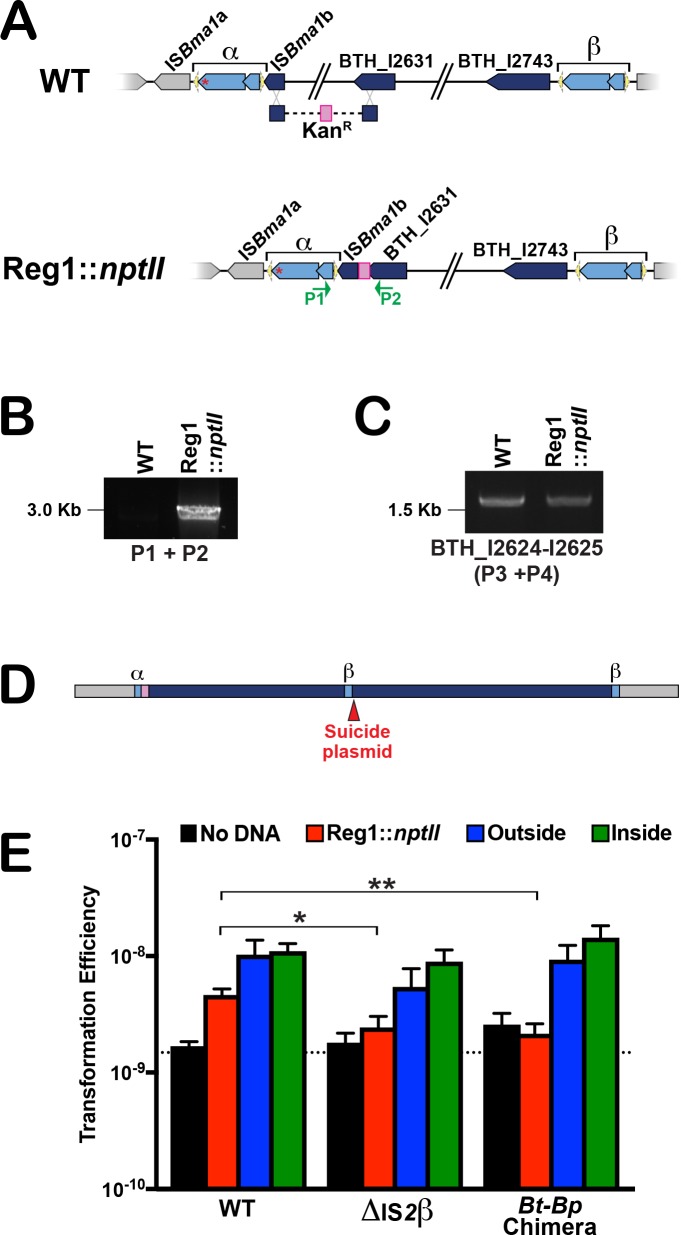
Evidence for intracellular movement of the IS2-like megacircle.(A) Diagram depicting the strategy used to replace the first ~48 kb (Region 1) of the bcpAIOB-containing putative composite transposon (dark blue) with a cassette containing the gene that confers kanamycin resistance, nptII, and FRT-binding sites (pink). (B) PCR analyses to confirm removal of Region 1 in strain Reg1::nptII using primers P1 and P2 (shown as green arrows in panel A) which are close enough to generate a product only after deletion of the ~48 kb region. (C) PCR analyses of WT BtE264 and strain Reg1::nptII using primers P7 and P8, which would amplify two genes from within the Region 1 sequence. (D) Integration of a suicide plasmid (red arrowhead) within the Region 1 sequence of the mobilized element, followed by plasmid rescue studies, suggests that the mobilized megacircle inserted adjacent to the truncated composite transposon carrying Reg1::nptII mutation. (E) Comparison of the transformation efficiencies upon deletion of Region 1 in strains that are positive (WT) or deficient (ΔIS2β and Bt-Bp chimera) in the production of the megacircle. No DNA, black bars; DNA to introduce the Reg1::nptII mutation, red bars; DNA to introduce an nptII cassette outside of the putative composite transposon, blue bars; DNA to introduce an nptII cassette inside the putative composite transposon, green bars. Horizontal dashed line represents the average lowest limit of detection. P values were obtained using Mann-Whitney U test comparing mutant strains to WT when the same DNA (or no DNA) was added. Results are shown as mean +/- SEM of three independent experiments with three technical replicates each (n = 9). *P < 0.05; **P < 0.01.